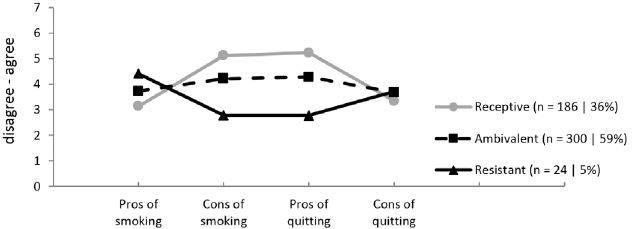
Fig 1. Mean scores on pros and cons of smoking and quitting in hardcore smokers. Higher scores indicate higher average agreement with pros or cons.